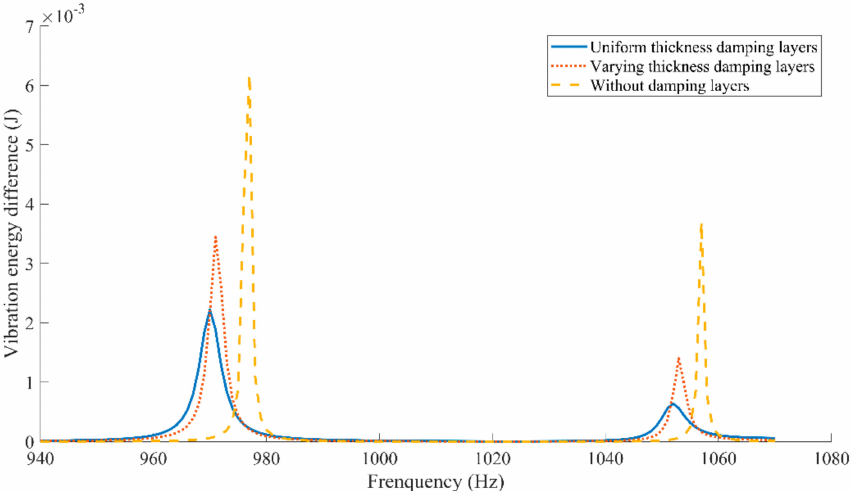
Figure 16. The vibration energy difference of ABH plates embedded with different damping configu- rations with BC